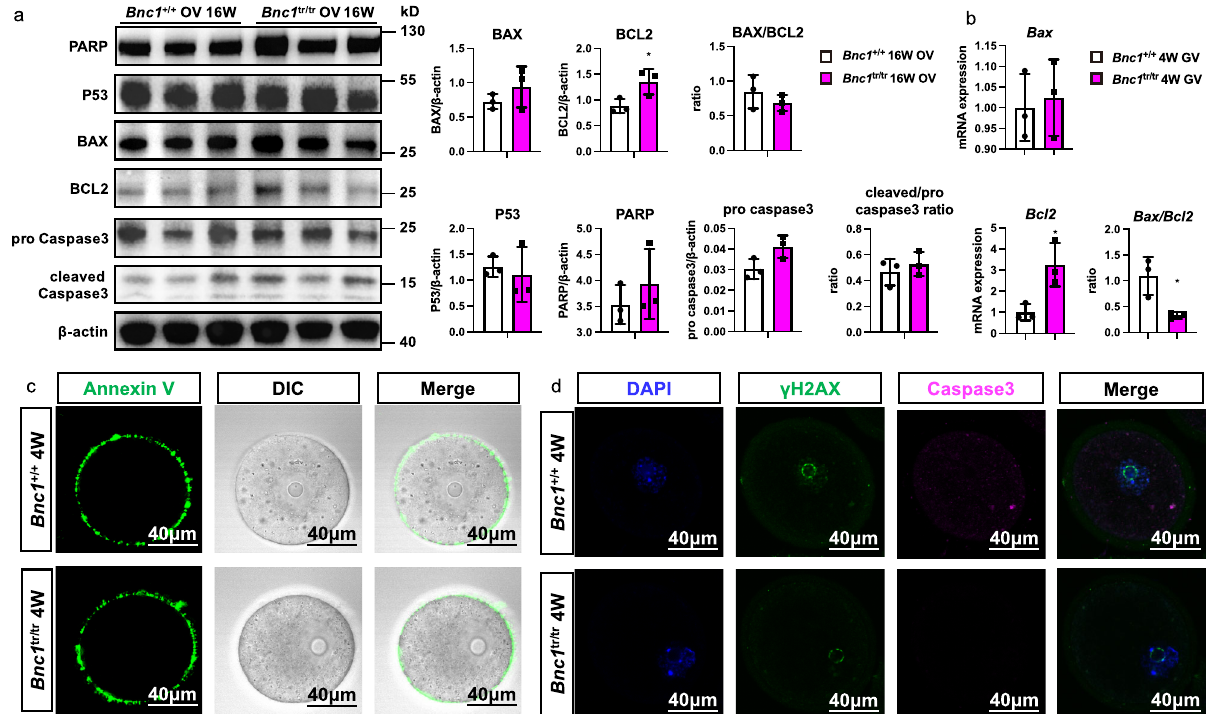
Fig. 3 | Bnc1 mutation induces follicular atresia through nonapoptotic cell death. a Ovaries were obtained from Bnc1 +/+ ( n =3) and Bnc1 tr/tr mice ( n =3) at 16 weeks old for western blotting (WB). The expression levels of P53, Bcl2, Bax, PARP, Caspase3 and cleaved-caspase3 are shown ( p value=0.6585 for P53, p value=0.0457 for Bcl2, p value=0.3090 for Bax, p value=0.3467 for BAX/BCL2, p value=0.0624forCaspase3, p value=0.4892forcleaved-Caspase3/Caspase3and p value=0.4162 for PARP). b GV oocytes were obtained from Bnc1 +/+ ( n =3) and Bnc1 tr/tr ( n =3) mice at 4 weeks old for real-time PCR. The mRNA expression of Bax and Bcl2 is shown ( p value=0.7446 for Bax , p value=0.0241 for Bcl2 and p